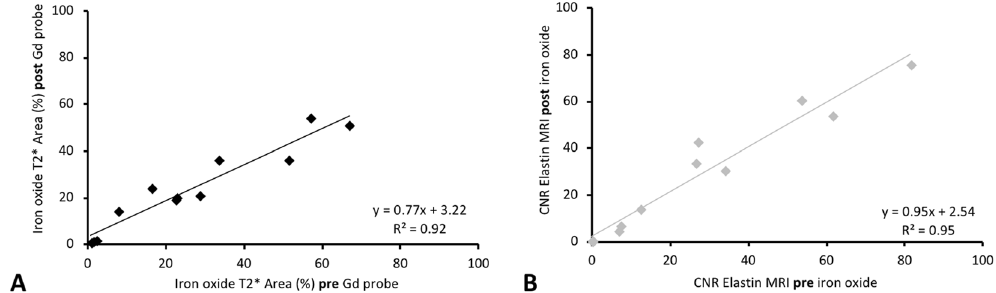
Figure 3. Influence of the gadolinium-based elastin-specific probe on the visualization of iron-oxide-particles and vice versa. If a multi-target approach is chosen, it is of high clinical importance, that the respective imaging probes do not affect the measurements on the other probe. ( A ) To investigate the influence of iron-oxide- particles on the assessment of the elastin-specific-agent on T1-weighted images, imaging was performed on day one prior to the administration of the iron-oxide-particles and 24-hours following the administration of the iron-oxide-particles. CNR-measurements of the elastin-specific MR-probe showed a strong correlation between both days. ( B ) To investigate the influence of the gadolinium-based probe on the assessment of the iron-oxide-particles on T2 * -weighted-sequences, imaging was performed on day two prior to and following the administration of the elastin-specific probe. The assessment of the effect of iron-oxide-particles on T2 * - weighted images prior to the administration of the gadolinium-based probe demonstrated a strong correlation with measurements following the administration of the gadolinium-based